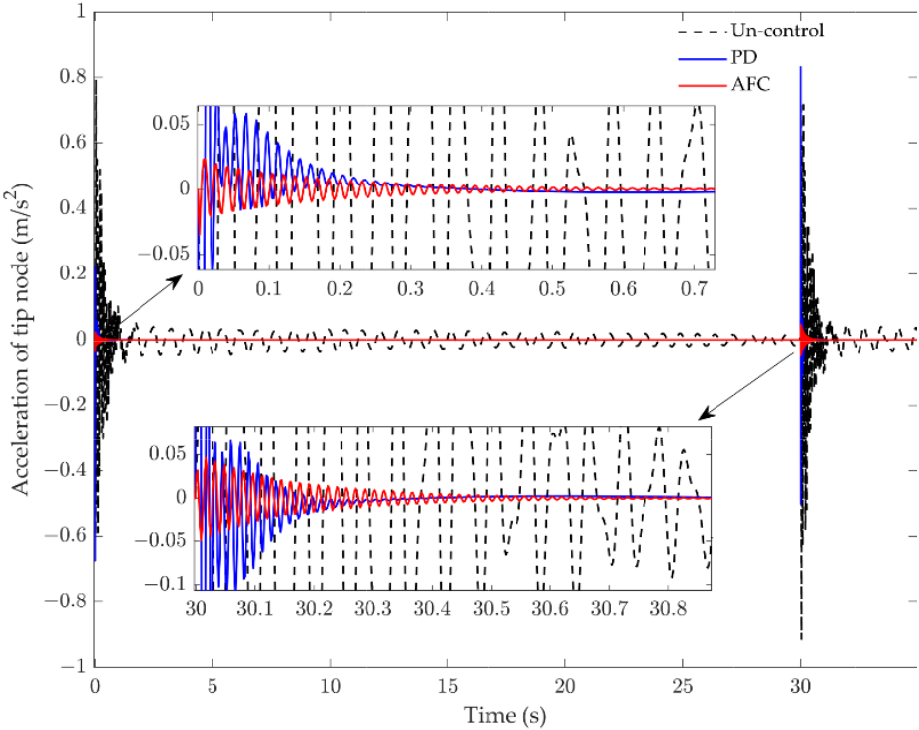
Figure 17. Simulation result of acceleration response for case 2.